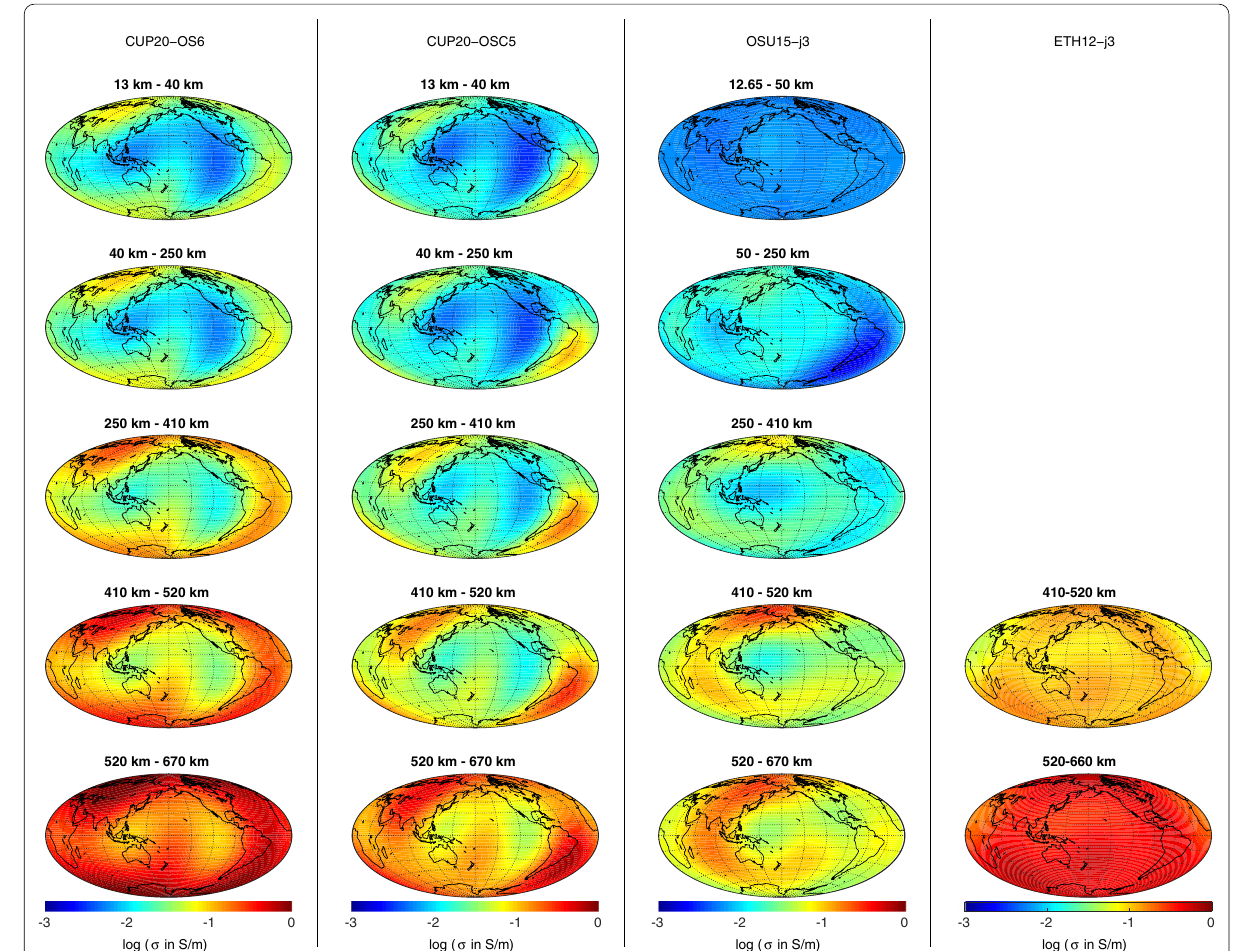
Fig. 5 Cross-sections of electrical conductivity models CUP20-OS6, CUP20-OSC5, OSU15-j3, and ETH12-j3 in the upper